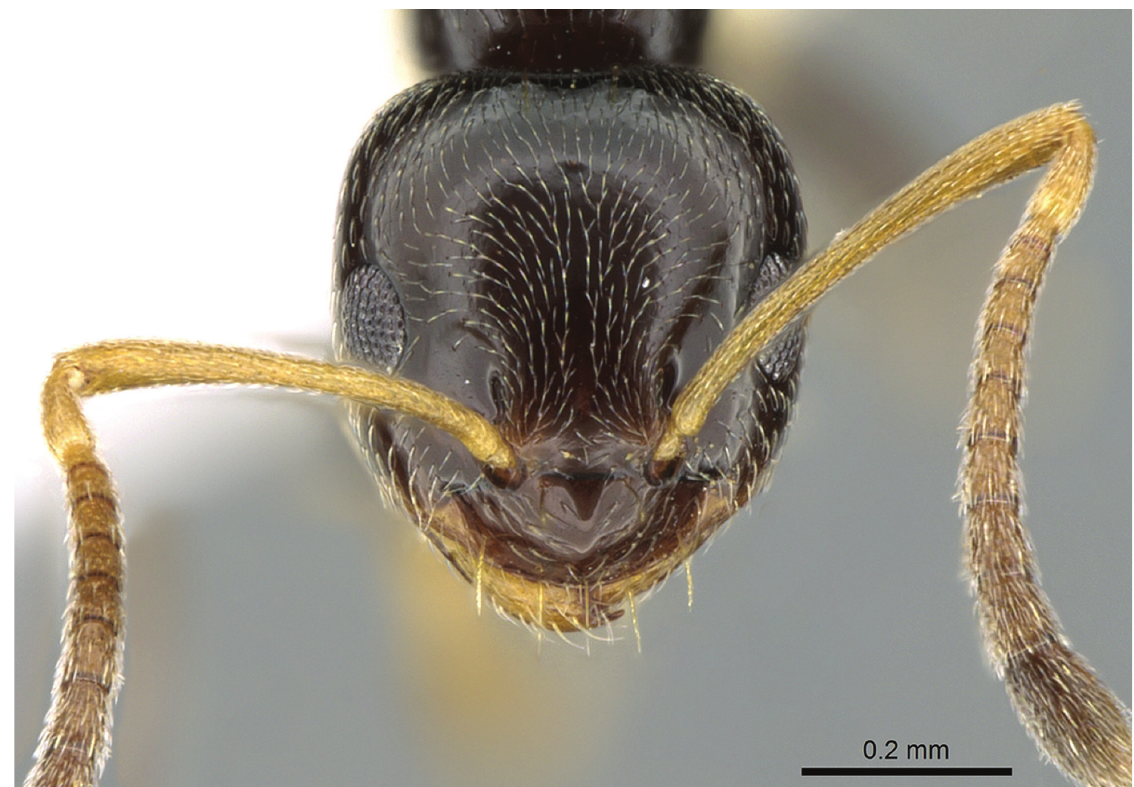
Figure 2. Head of a worker of Plagiolepis schmitzii (image from AntWeb, 2020: CASENT0906252 , photographer E. Ortega).